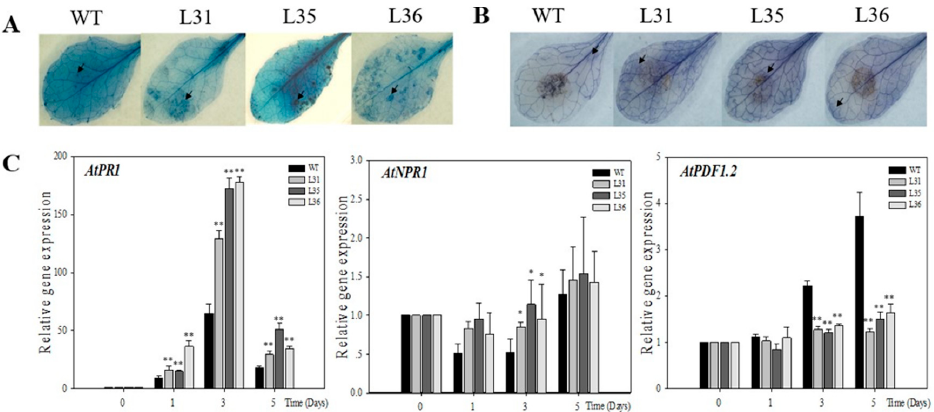
Figure 3. Expression of defense-related genes after VqSTS36 transgenic Arabidopsis inoculated with Botrytis cinerea . ( A ) Trypan blue staining to detect cell death after 3 days plants subjected with B. cinerea. ( B ) Trypan blue staining to detect cell death. ( C ) Relative expression levels of defense-related genes in leaves collected at 0, 1, 3 and 5 days post-inoculation (dpi). Data represent mean values ± SD (with values from time point 0 hpi set to 1) from three independent experiments. Asterisks indicate significant differences between WT and transgenic lines as determined by Student’s t -test (* 0.01 < p < 0.05; ** p < 0.01).